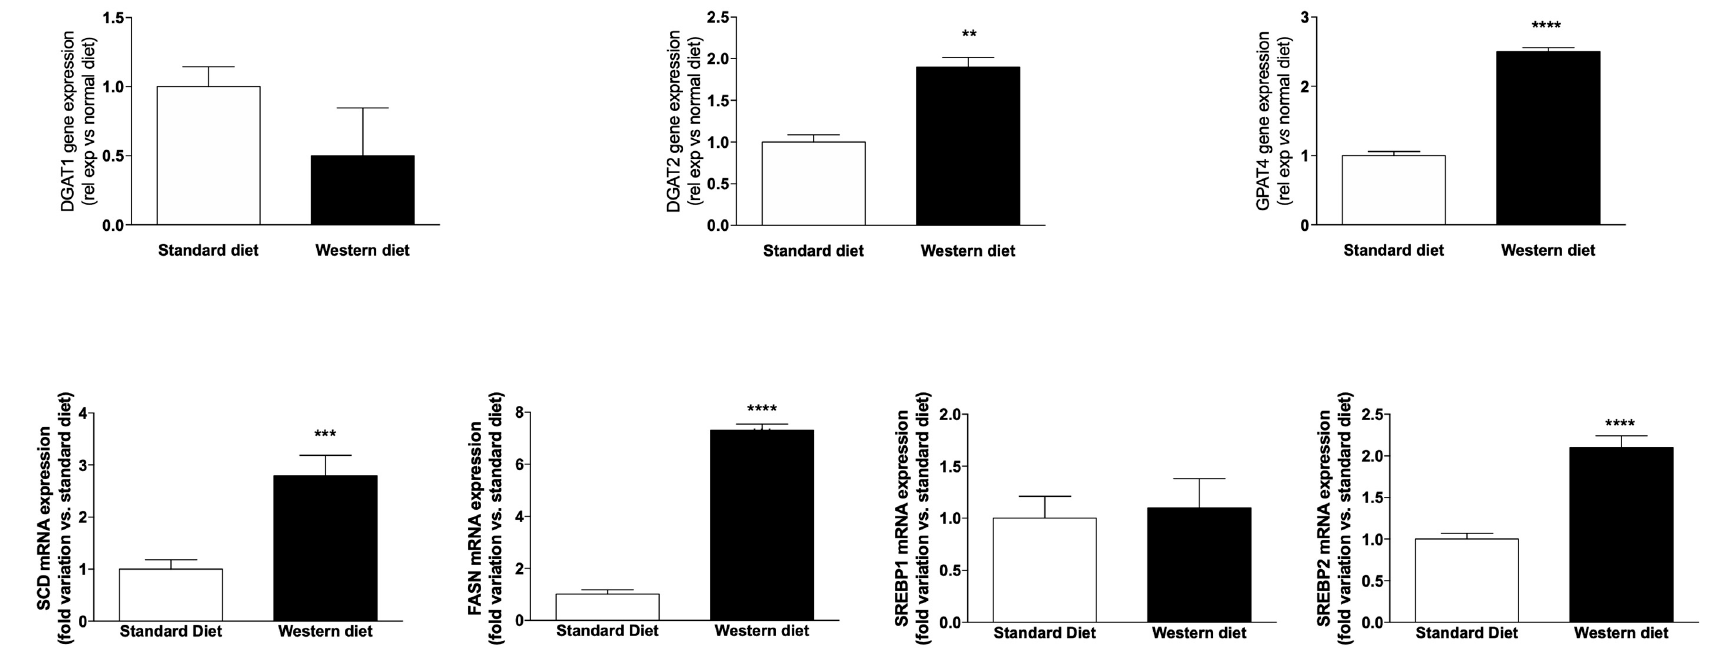
Figure 3. mRNA expression of genes involved in lipid synthesis and metabolism. ** p < 0.01, *** p < 0.001 and **** p < 0.0001 vs. rats fed with standard diet.